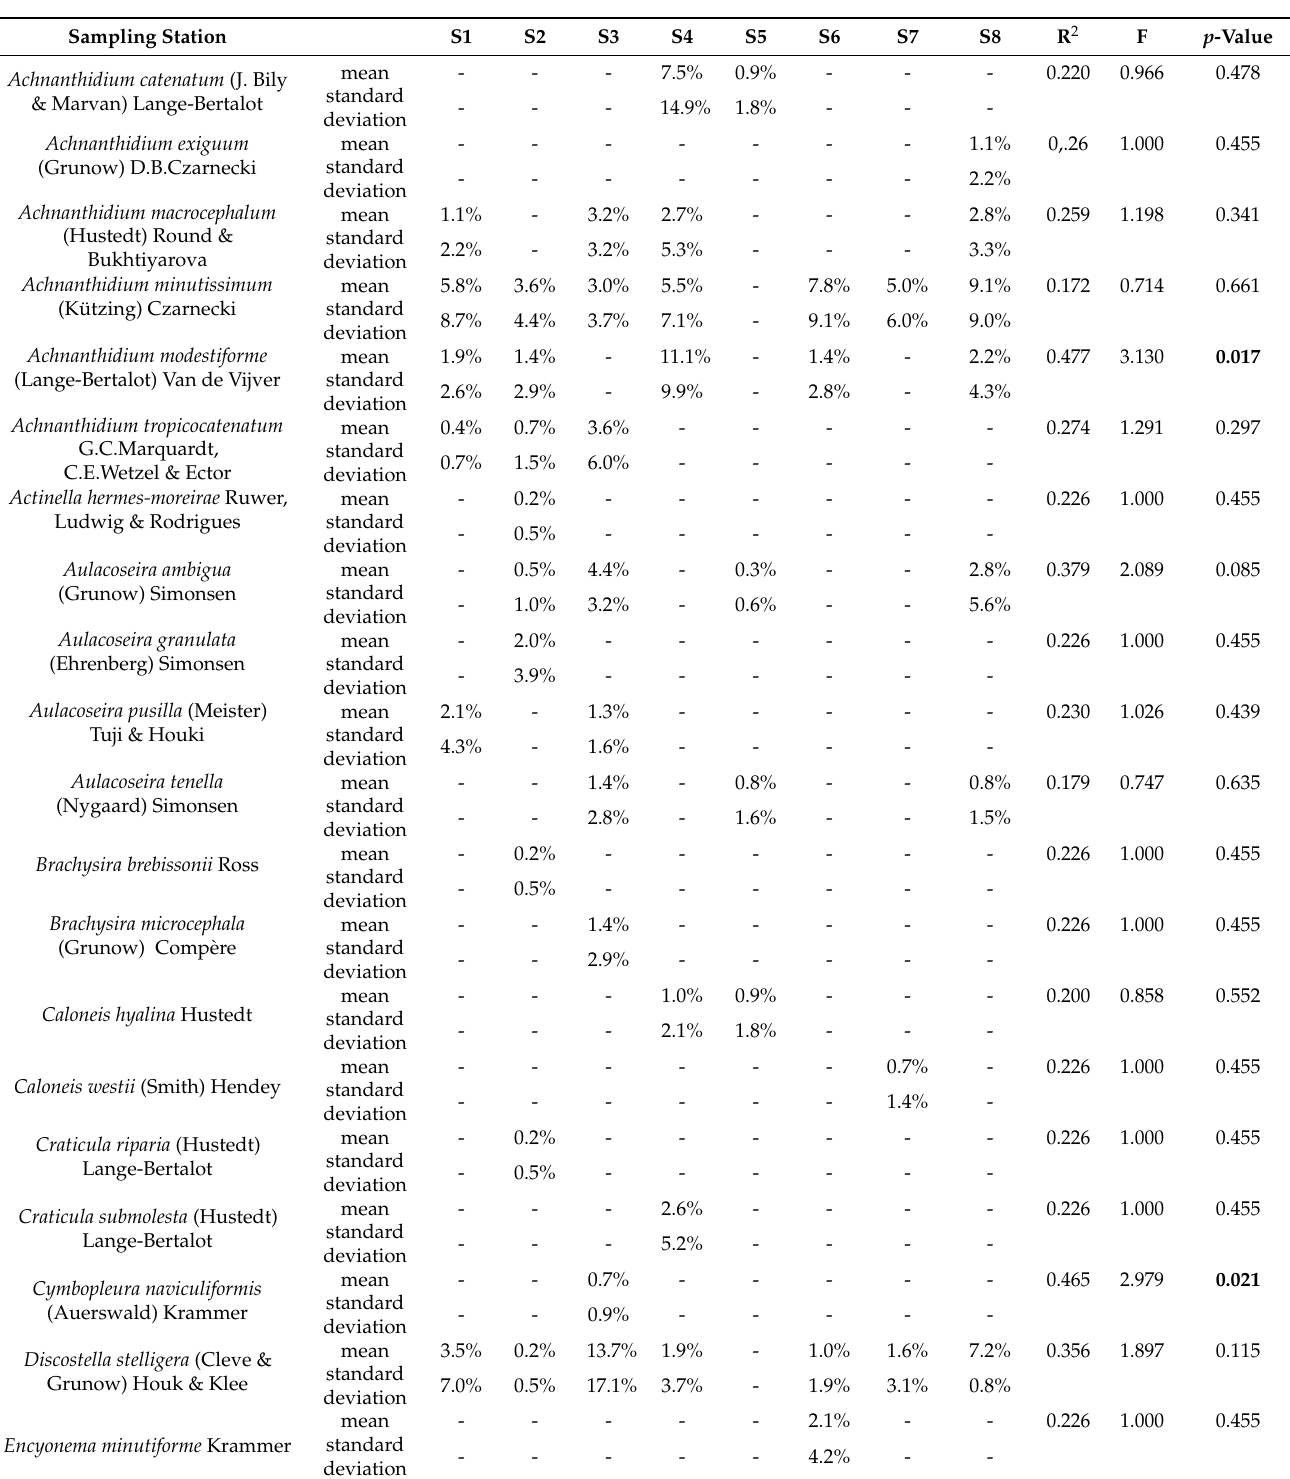
Table A1. Analysis of variance (Anova) to compare the means of relative abundance of each diatom species according to the sampling stations. Species that had significantly different means across sampling stations, p < 0.05, have p -value highlighted in